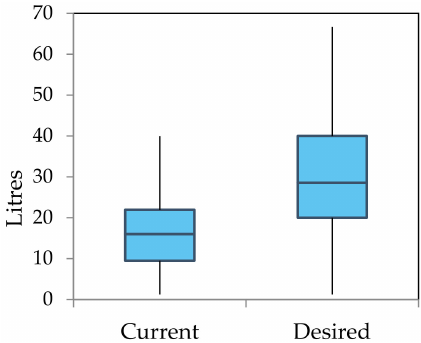
Figure 1. Box plot of the current and desired amounts of water available per person per day from the survey conducted (Supplementary Material